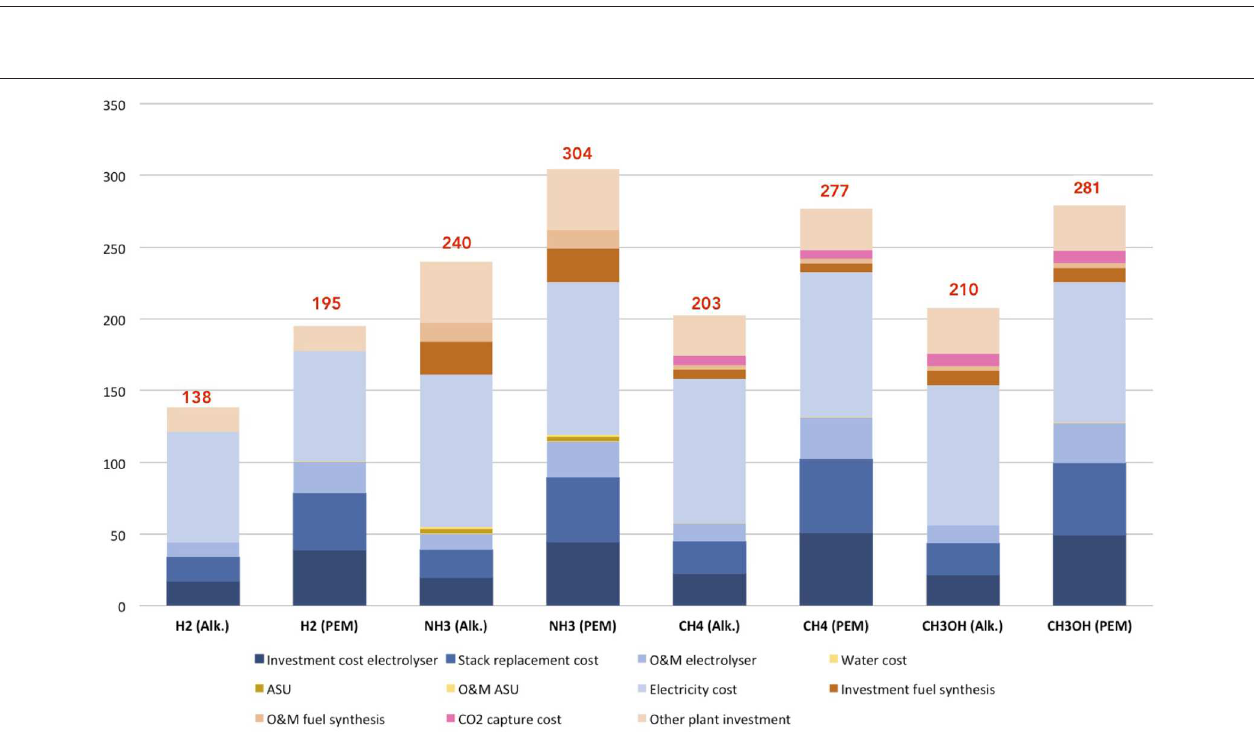
FIGURE 6 | Production costs for each fuel in e /MWh fuel , with alkaline and PEM electrolysers.